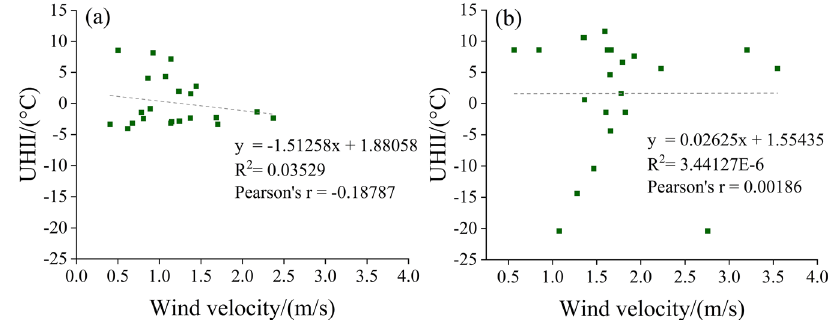
Fig. 7 The relationship between sea – land breeze wind speed and heat island intensity. a Land breeze, b sea breeze.